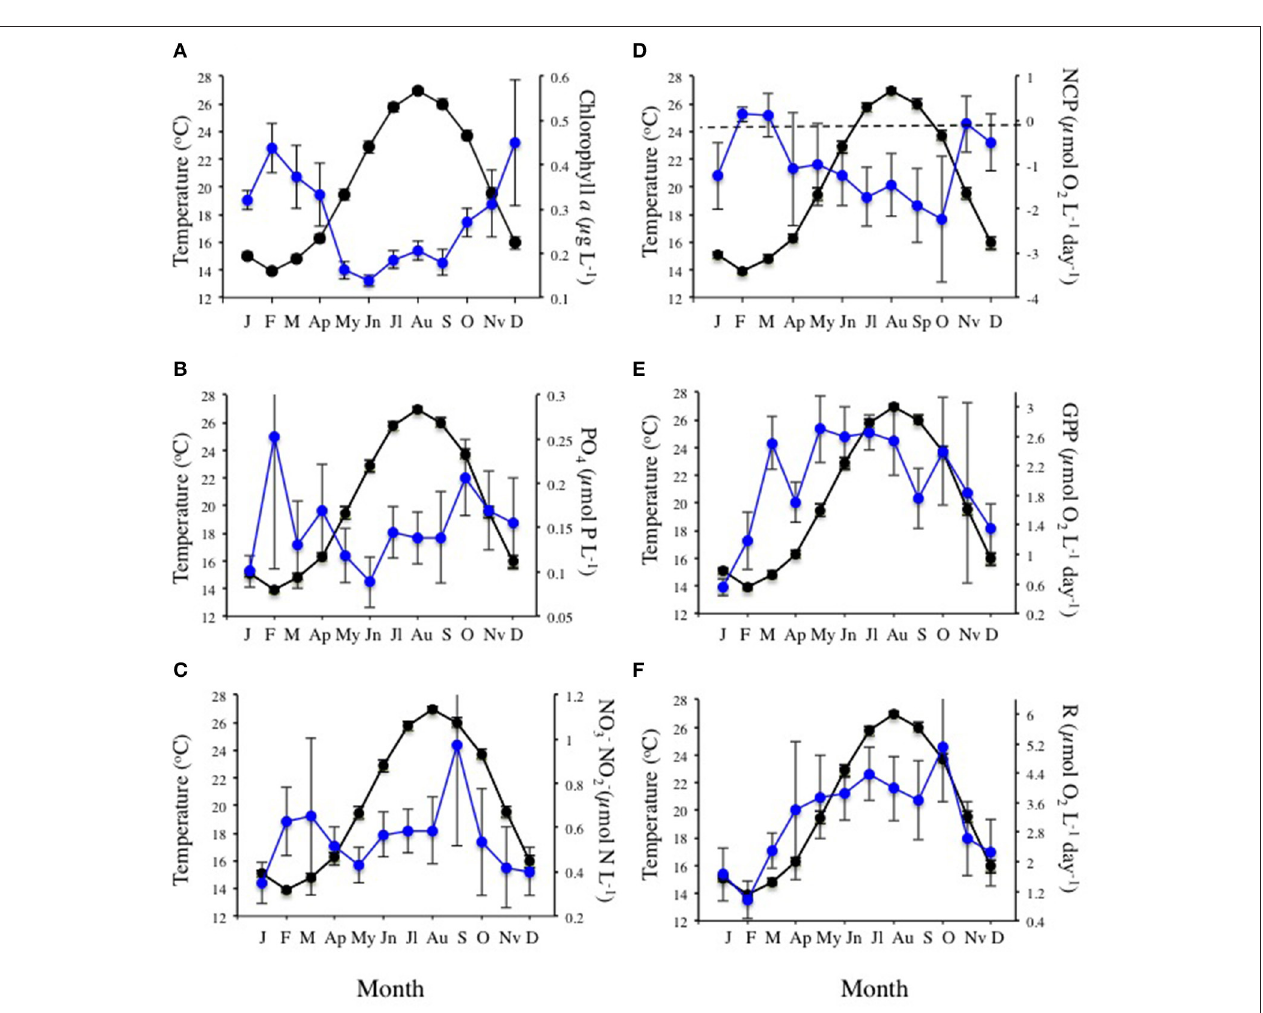
FIGURE 1 | Mean ( ± SE) monthly sea surface temperature (black dots and continuous lines) and (A) chlorophyll a concentration, (B) phosphate concentration, (C) nitrate + nitrite concentration, (D) net community production (NCP), (E) gross primary production (GPP), and (F) community respiration (R), in Cap Salines coastal waters (Mediterranean Sea) along the observation period (January 2006 -December 2015). The bars encompassed the SE. The dotted line in plot (D) marks balanced NCP.